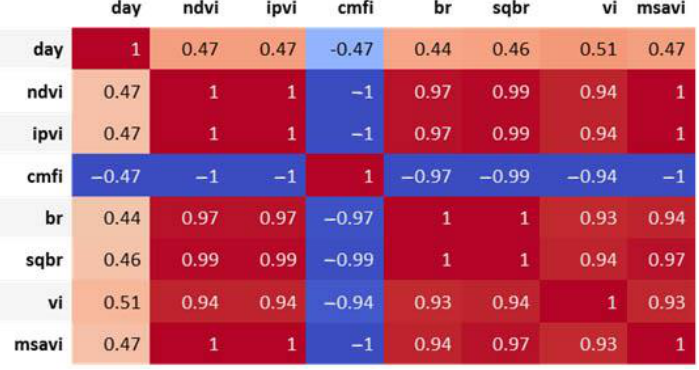
Figure 19. High or even complete correlations between pairs of vegetation index features. Table 2. Correlation analysis between vegetation indices and cabbage growth stages. Vegetation